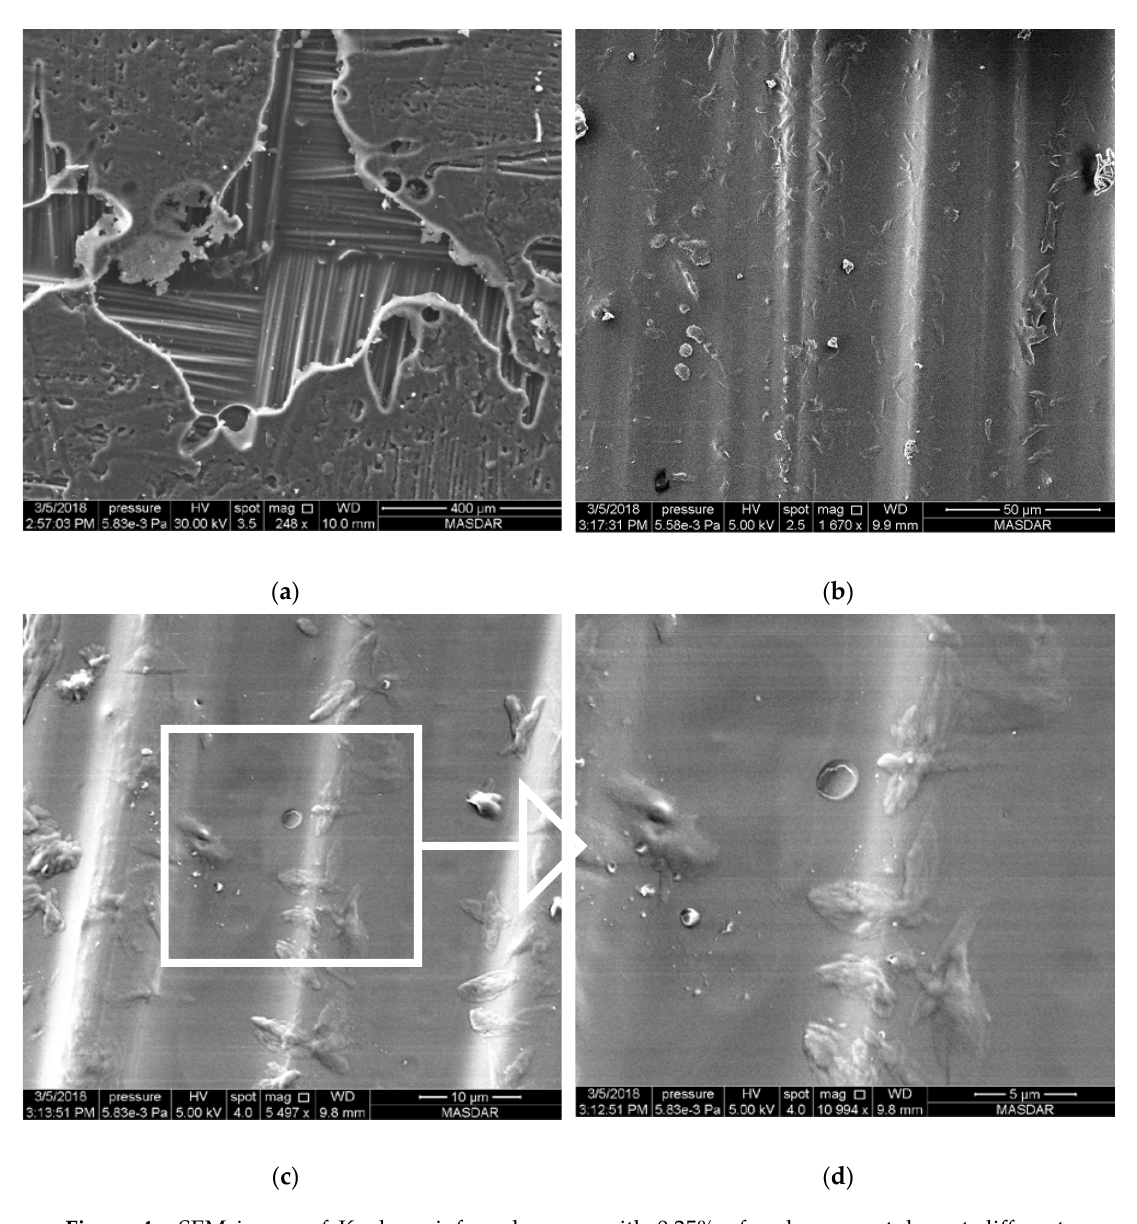
Figure 4. SEM image of Kevlar reinforced epoxy with 0.25% of carbon nanotubes at different magnifications. ( a ) 248×, ( b ) 1670× ( c ) 5497× ( d ) 10,994×.